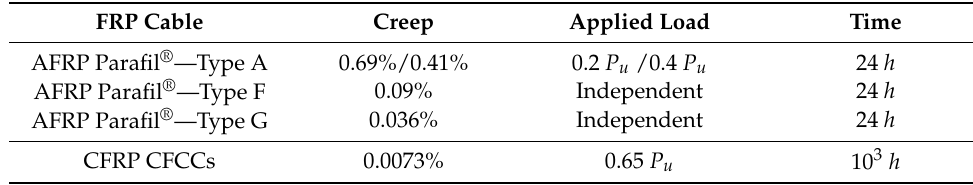
Table 2. FRP composite tendons: creep properties.